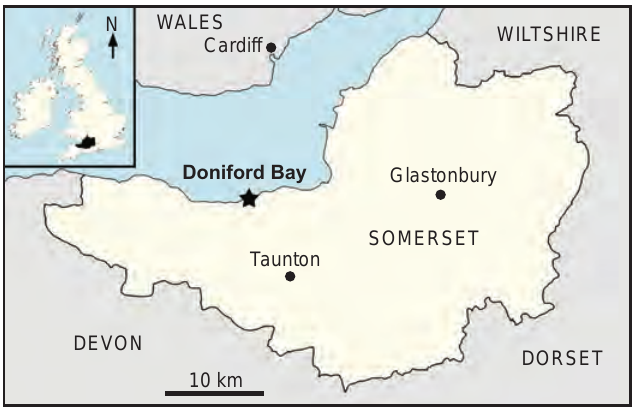
Fig. 1. Map of Somerset including the location of Doniford Bay (indicated by a star), Watchet, UK.